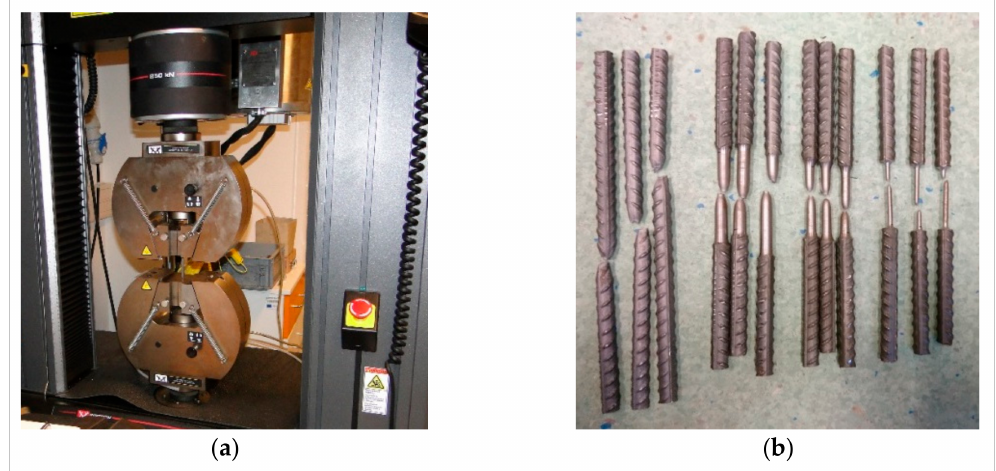
Figure 2. Test procedure: ( a ) Testing machine and ( b ) rebars.